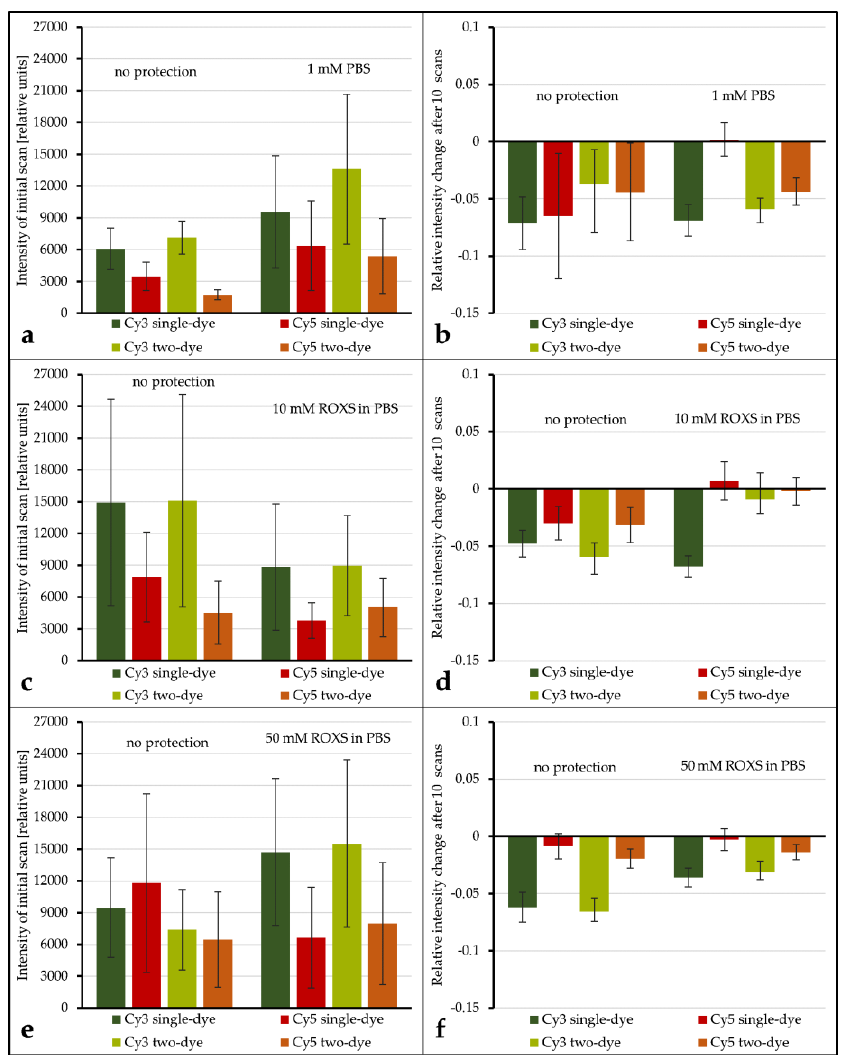
Figure 5. Examination of the influence of protective measures on the mean spot intensity level and the spot intensity percent change after 10 scans. Intensity levels are derived from Array1: unprotected vs. PBS ( a ), Array2: unprotected vs. 10 mM ROXS ( c ), and Array3: unprotected vs. 50 mM ROXS ( e ). Spot intensity percent changes after 10 scans are derived from Array1: unprotected vs. 1 × PBS ( b ), Array2: unprotected vs. 10 mM ROXS ( d ), and Array3: unprotected vs. 50 mM ROXS ( f ). Intensity information derived from hybridizations of Cy3/Cy5 vs. unlabeled cDNA is tagged “single-dye” while intensity information derived from hybridization of Cy3-labeled cDNA with Cy5-labeled cDNA is tagged “as two-dye”. Error indicators are the respective standard errors of the mean (confidence: 95.4%) with Gaussian error propagation.